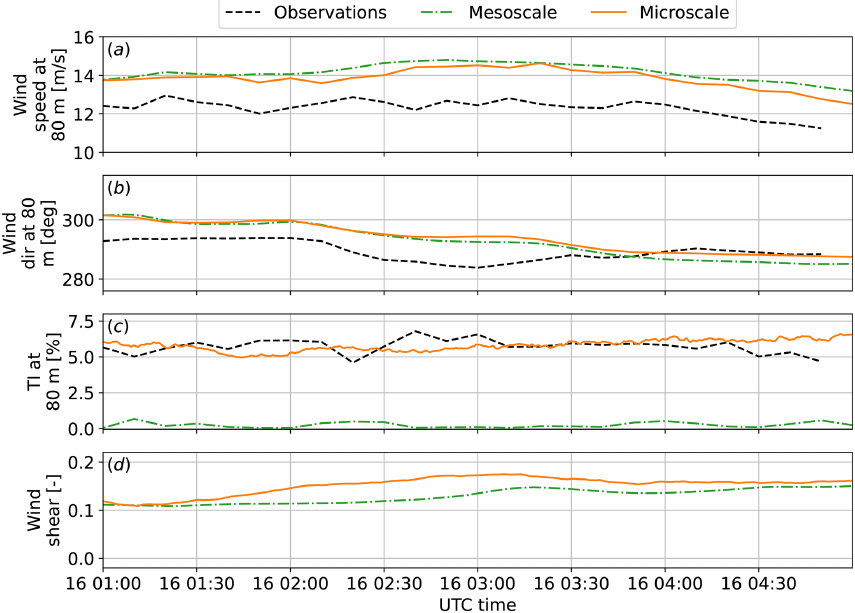
Figure 2. Mean background conditions during the period of interest compared to observation data and the mesoscale solution used to drive the microscale LES. (a) Wind speed, (b) wind direction, and (c) turbulence intensity at 80m and (d) wind shear